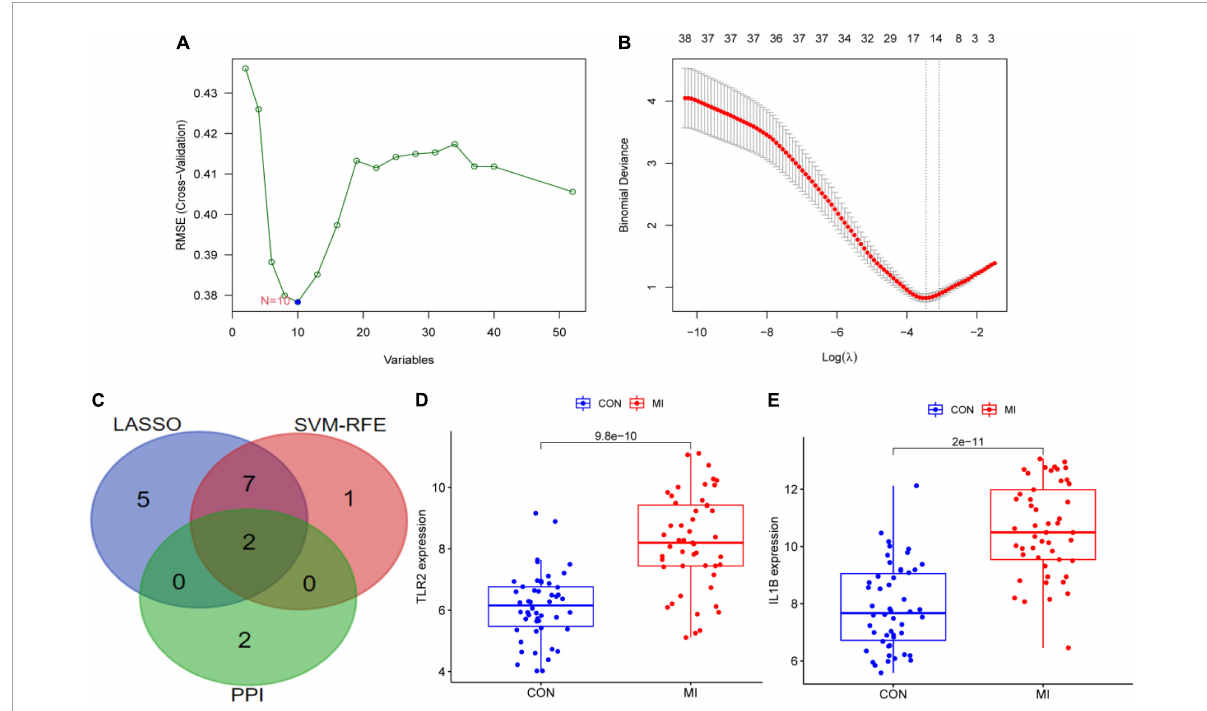
FIGURE6 The screening of hub DEGs using machine learning and PPI. (A) 10 DEGs were obtained using the SVM-RFE algorithm. (B) 14 DEGs were obtained using the LASSO regression algorithm. (C) A Venn diagram presented the hub DEGs. (D) The expression levels of TLR2 in GSE66360. (E) The expression levels of IL1B in